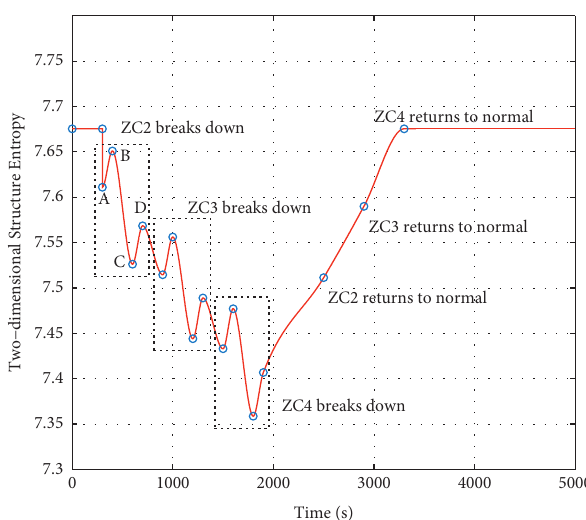
Figure 5: Network performance changes of the CBTC system under scenario 1.